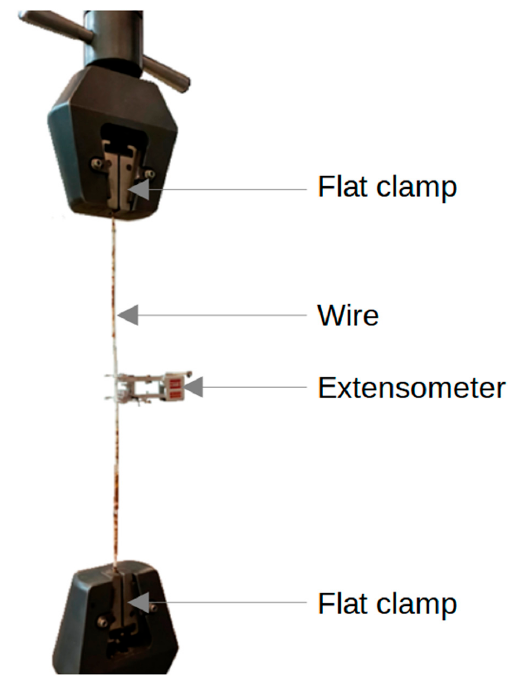
Figure 4. Tensile test bench made at the University of Sherbrooke.